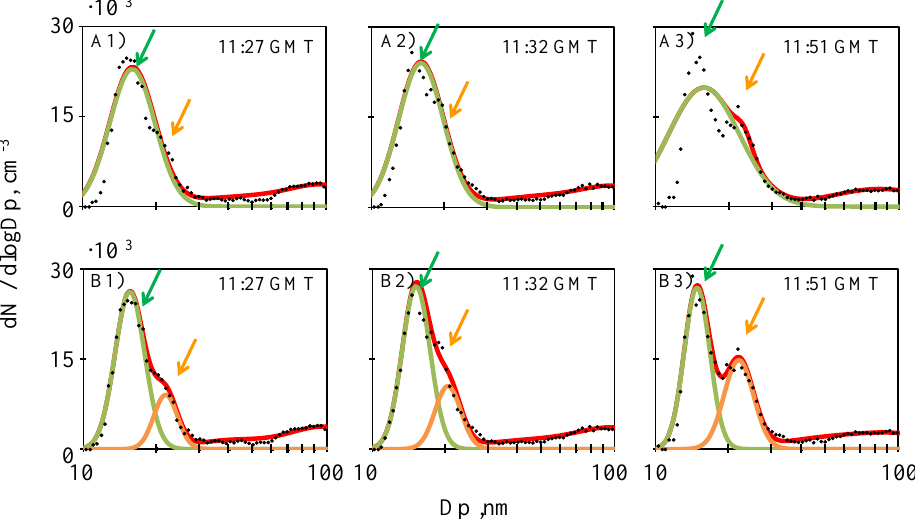
Fig. 13. Example of a banana-type Ia event (30 May 2009) in which two nucleation modes were observed (highlighted with green and orange arrows). (A) Fitting to 2 lognormal distributions with one nucleation mode (green line). (B) Fitting to 3 lognormal distributions with two nucleation modes (green and orange lines). Black dots represent measured data; red line represents the sum of all the fitted modes.